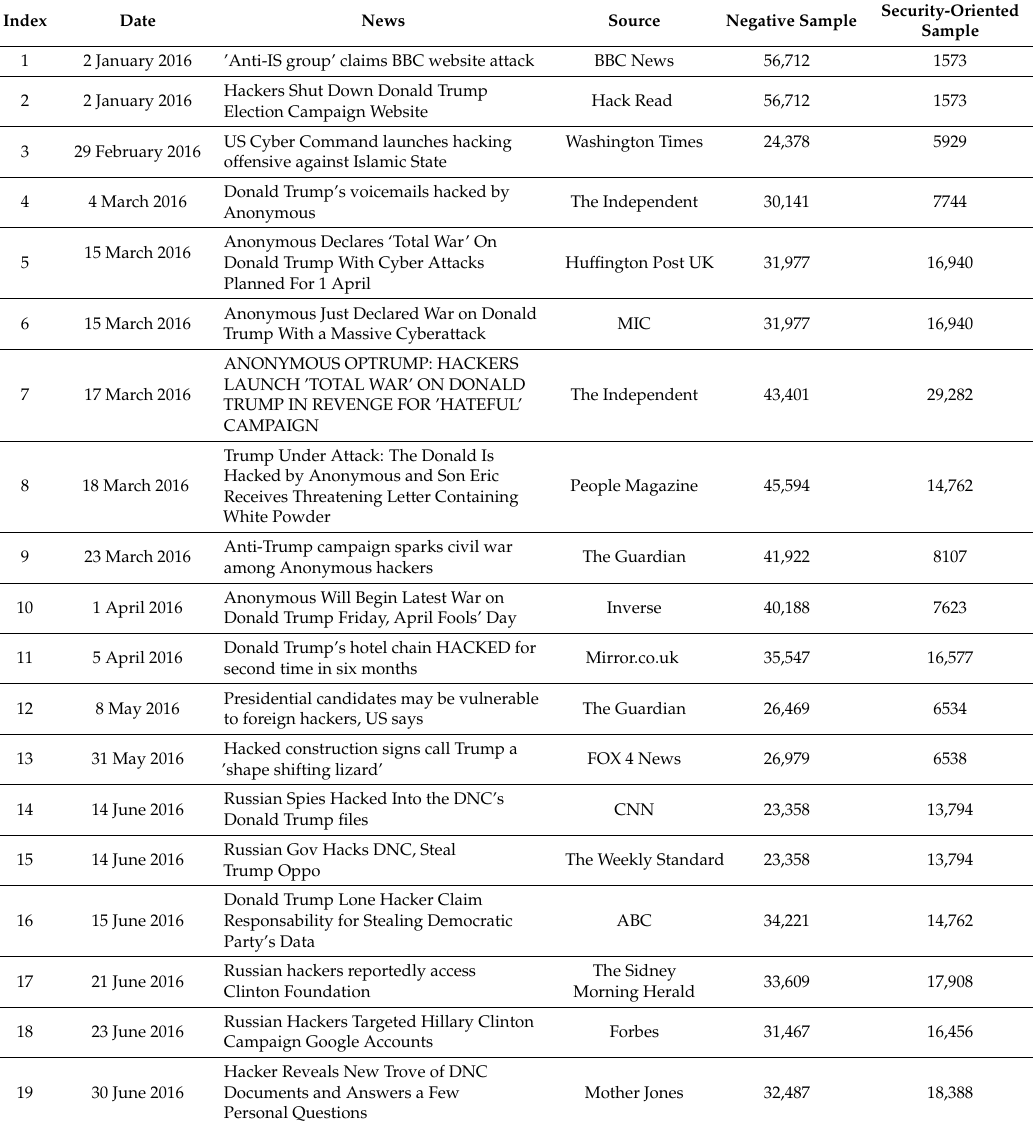
Table 7. News reporting security-related